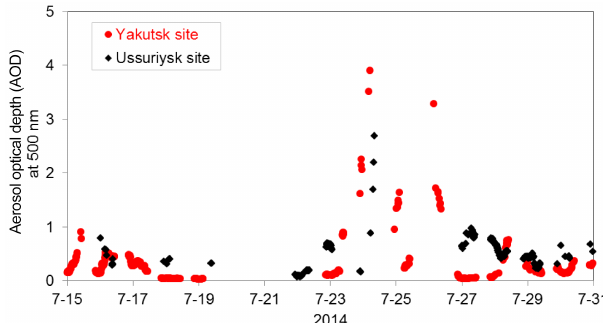
Figure 5. Temporal variations in AOD measured by a sun photome- ter at the Yakutsk and Ussuriysk sites in Russia during July